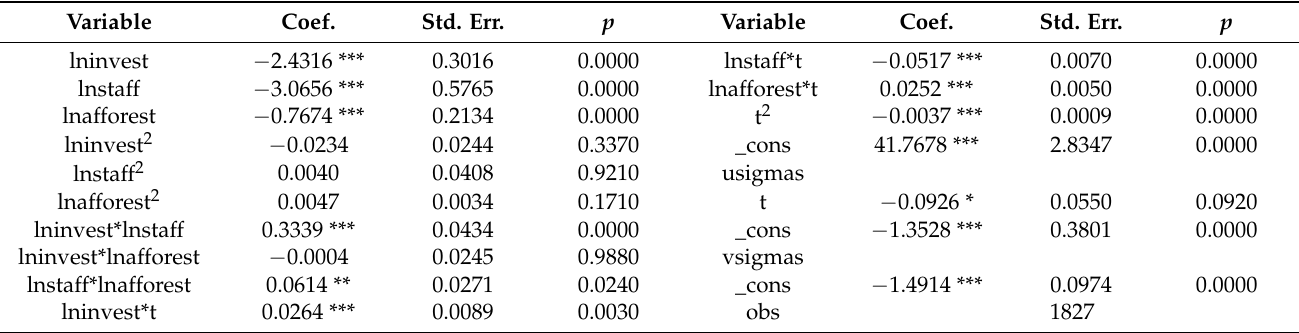
Table 4. SFA model